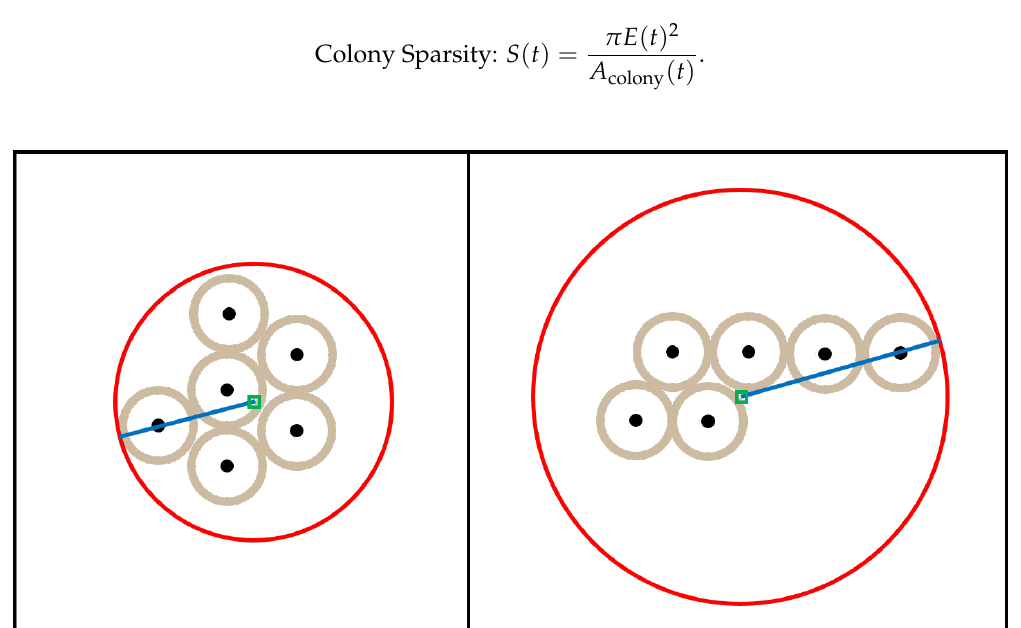
Figure 15. Colony Sparsity and Expanse. We first compute the colony center of mass (represented as a green square) using Equation (13). Then we determine the radius (length of the blue line) of the smallest circle which surrounds the entire colony centered at the center of mass (shown in red) using Equation (14). The colony sparsity is then computed using Equation (16) with the result of Equation (14), the area of the circle, and the total area of the cells using Equation (15). (Left): The space within the circle is more dense, thus covering more area within the circle with radius equal to the colony expanse, resulting in a small colony sparsity. (Right): The space that cells occupy within the circle is less dense, resulting in a higher colony